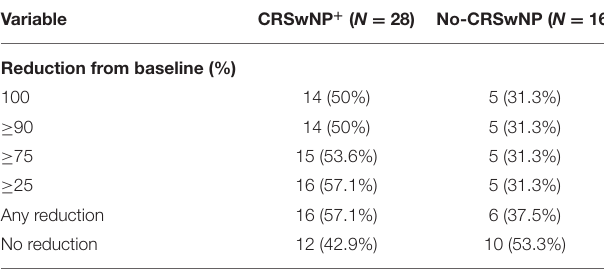
TABLE 2 | Oral corticosteroid (OCS) reduction at end of observation in the patient population.